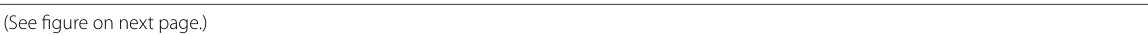
Fig. 5 IgG78‑DM1 could prevent liver fibrosis in CCl 4 ‑induced mice. A Schematic of the experimental design for the establishment and treatment of CCl 4 ‑induced mice. B IF staining showing the localization of IgG78‑DM1 in the liver tissue of CCl 4 ‑induced mice. C Sirius Red staining showing that IgG78‑DM1 could alleviate liver fibrosis in CCl 4 ‑induced mice (n 5). D Quantification of the data in C . E Ishak score of the liver tissue. F The = hepatic hydroxyproline content after treatment. G Serum levels of ALT after treatment (n 5 in B – G ). H qRT‑PCR to show the mRNA levels of Cd248 = and fibrosis‑related genes ( Acta2, Col1a1, Tgfbr1 and Pdgfrα ) in the liver tissues. I Western blotting showing the protein levels of α‑SMA, collagen, and CD248 in liver tissues. J TUNEL staining showing the apoptosis of α‑SMA‑positive HSCs in liver tissues. K Quantification of the data in J (n 3 = in H – K ). Representative images are shown. Scale bar, 100 μm, ** p < 0.01, *** p < 0.001, **** p < 0.0001. DM1 Mertansine, HSC hepatic stellate cell, IF immunofluorescence, ALT alanine aminotransferase, qRT-PCR quantitative real‑time reverse transcription polymerase chain reaction, α-SMA alpha smooth muscle actin, TUNEL terminal deoxynulceotidyl